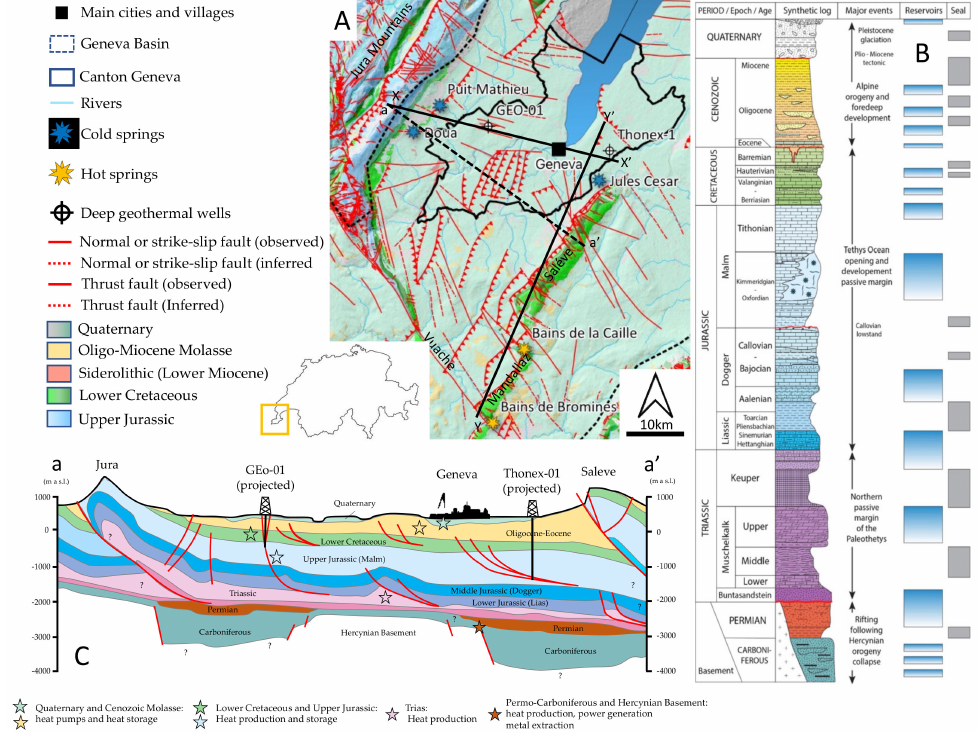
Figure 1. ( A ): Geologic map of the Geneva Basin with indication of the sampled features. ( B ): Syn- thetic stratigraphic log of the Geneva Basin with indication of potential reservoirs and seals (modified from [7–9]); ( C ): Cross-section in the NW-SE direction, cutting across the Geneva